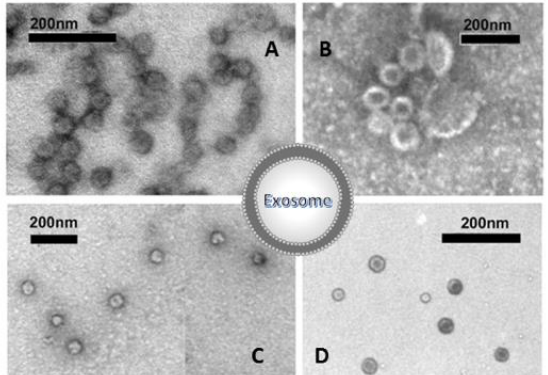
Figure 7. Electron microscopic view of individual exosomes. Whole-mount exosome preparations purified with ultracentrifugation and negative stained from plants ( A ), and different cell lines grown in culture ( B – D ). The cup-shaped morphology is clearly visible.